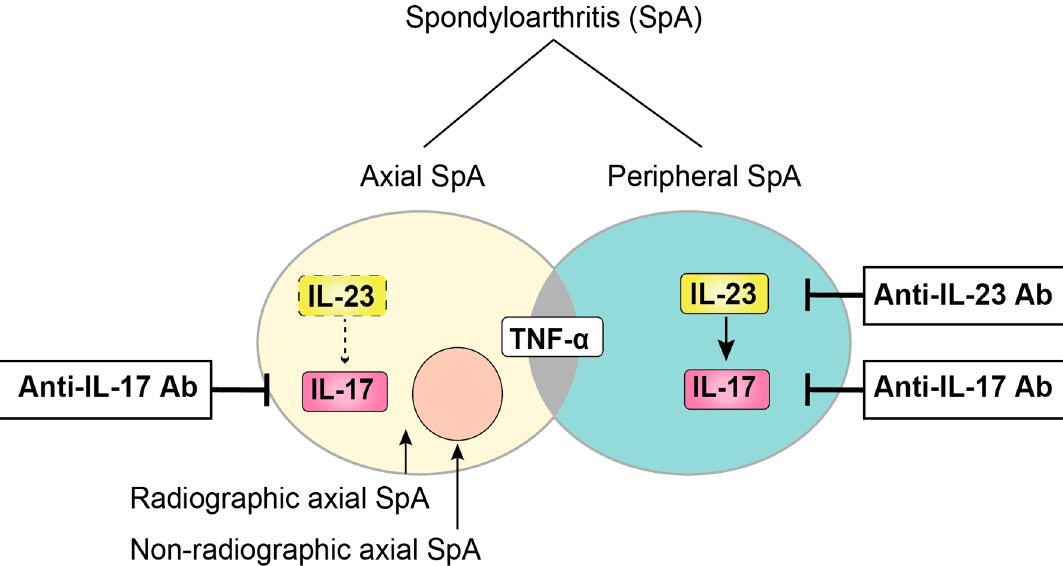
Figure 1. Schematic classification of SpA . SpA patients are mainly classified into two groups (axial SpA and peripheral SpA) based on their predominant clinical manifestation, with some overlap between these two groups. Axial SpA are further divided into two subtypes depending on whether there is radiographical bone destruction.